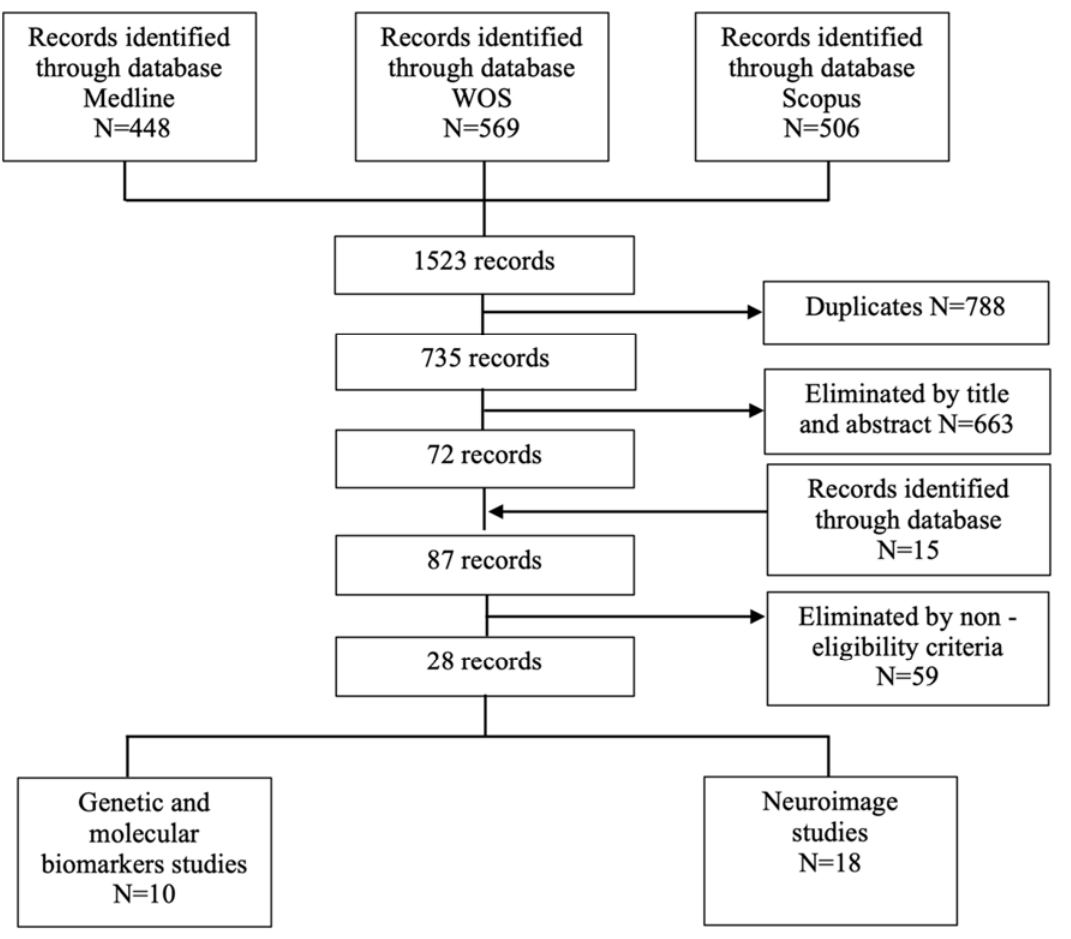
Figure 1. PRISMA block diagram depicting study search and selection process. WOS, Web of